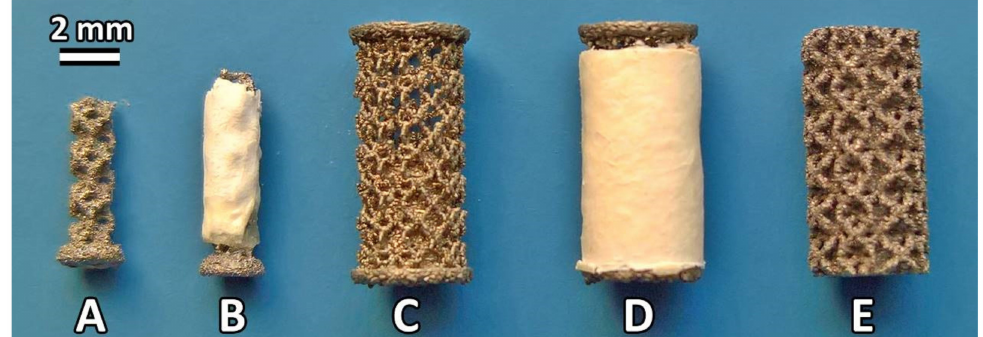
Figure 1. Representative images of the titanium implants. Ti printed implant before ( A ) and after ( B ) the deposition of a COLHA+V layer intended for use in the antimicrobial activity experiment; Ti printed implant before ( C ) and after ( D ) the deposition of a COLHA+V layer intended for use in the osseointegration experiment; Ti printed control sample ( E